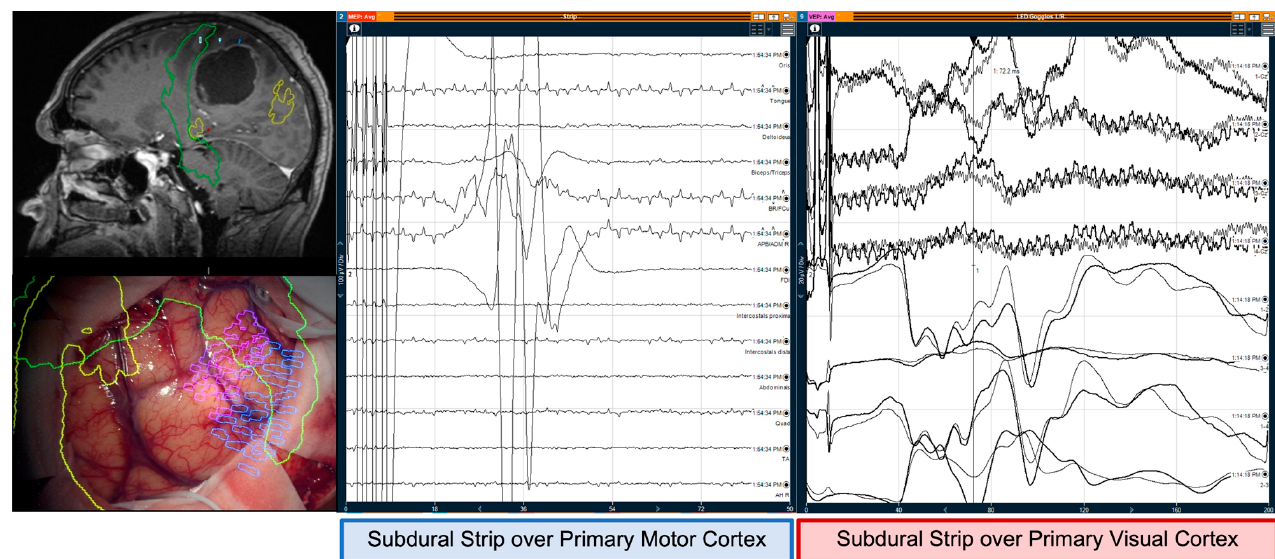
Figure 1. Example of a craniotomy for tumour resection with simultaneously motor and optic radiations’ mapping. The recordings from the subdural strip over primary motor cortex ( left ) show positive motor evoked responses from the right bicep/tricep, brachioradialis/flexor carpi ulnaris, abductor digiti minimi/ abductor pollicis brevis, and first dorsal interossei at 100 µ V amplitude and a latency of 36 ms, from direct cortical stimulation using the strip electrode with 5 anodal pulses, 500 µ s pulse width, at 10 mA, with software filters of 30–1500 Hz. The recordings from the subdural strip over primary visual cortex ( right ) show visual evoked potentials recorded using the direct cortically placed strip electrode over the calcarine fissure, from simultaneous stimulation of the bilateral eyes through LED goggles placed over the eyelids at 16,000 lx intensity and 3.1 Hz, using software filters of 10–300 Hz. Artefact can be observed on the VEP strip electrode recording channels referenced to Cz’ scalp electrode (top 4 channels with green arrows). The bottom 4 channels observed VEP waveform responses referenced to other channels on the same strip electrode, with the strongest and largest amplitudes seen on contact 1 referenced to contacts 2 and 4 (blue arrows) at 20 µ V, P2 peak at ~90 ms, N3 at ~98 ms, and P3 at ~120 ms however despite filters applied, peaks N1, P2, and N2 are difficult to identify due to external